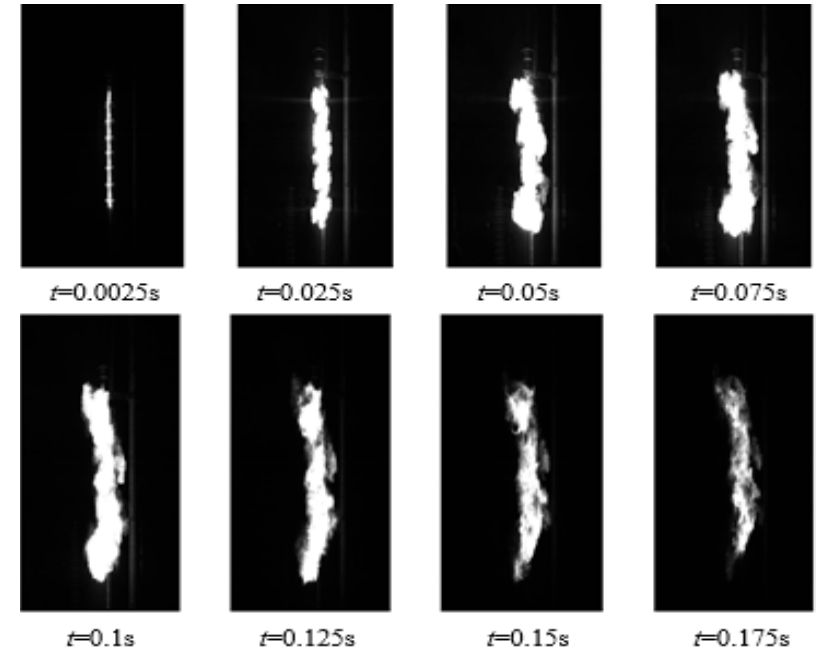
Figure 5. Short-circuit arc images at different times.